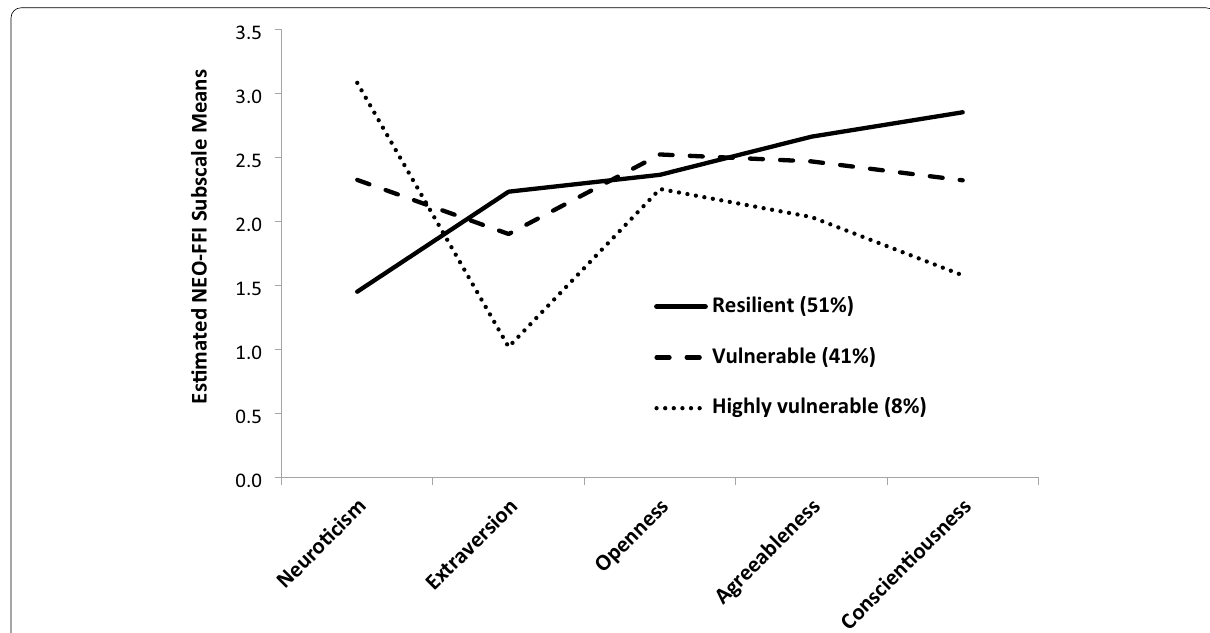
Fig. 2 Class-specific personality profiles for the 3-class model. NEO-FFI, NEO Five-Factor